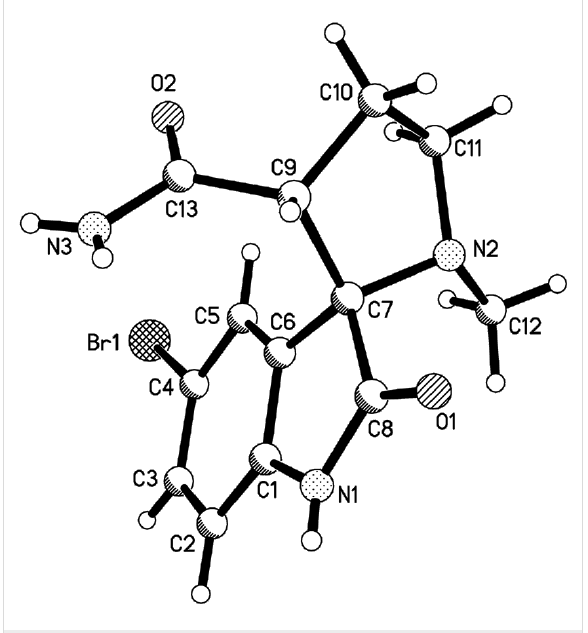
on the reactivity of the employed α -amino acid. The longest reaction time (7 h) was found for sarcosine, while the fastest reaction (40 min) was found for proline as a substrate (Table 1, entries 1 and 3).